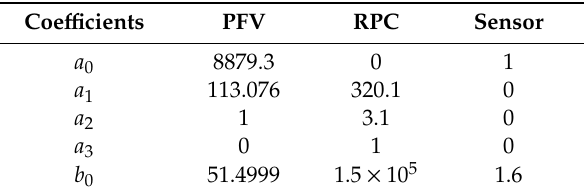
Table 1. The coe ffi cients in Equation (6) for the three